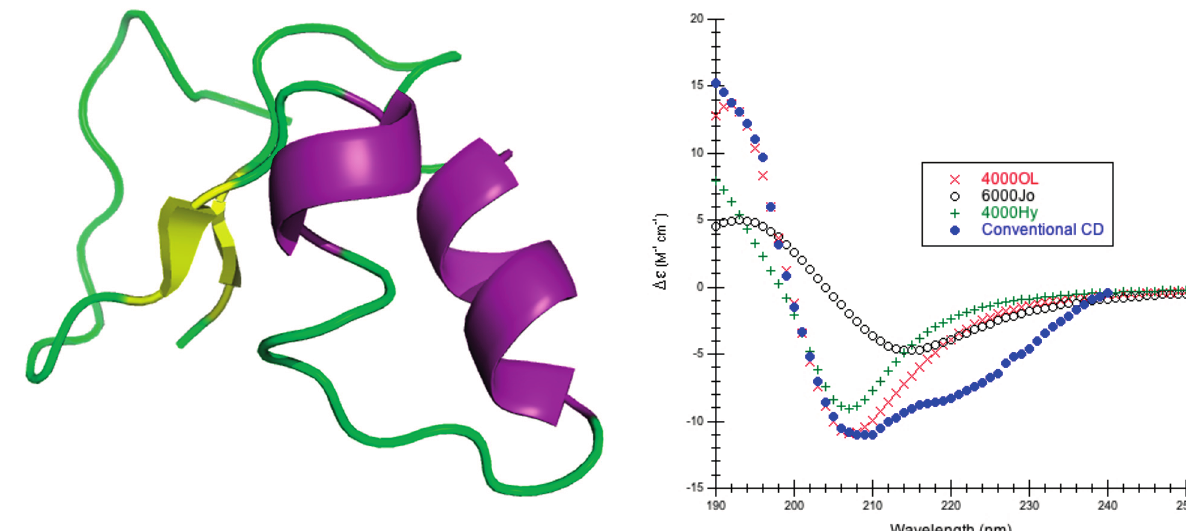
Figure 5. Crambin. ( Left ) Secondary structure of crambin (PDB code 1AB1 structure